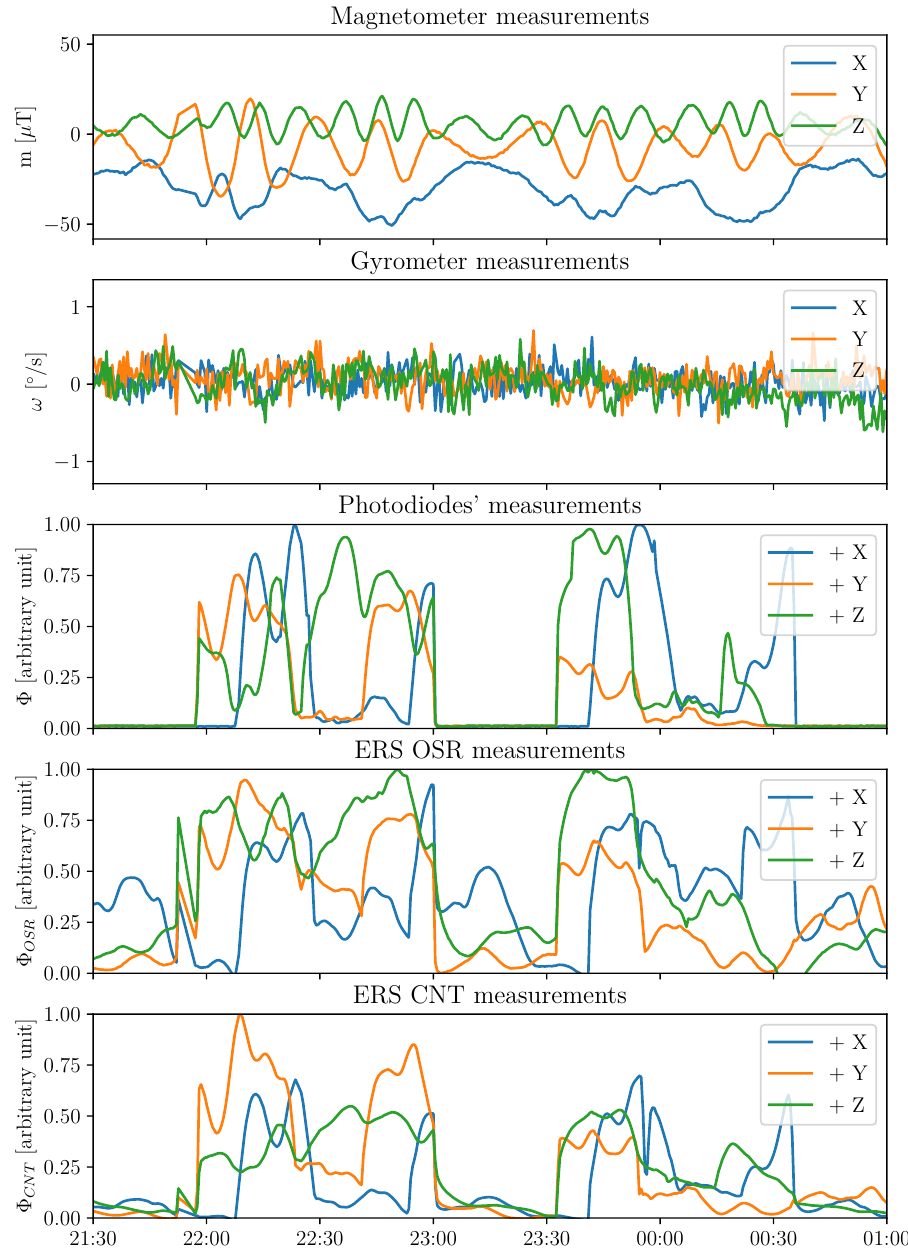
Figure 2. Time series of the measurements for two orbits on 26 March 2021 from the three-axis magnetometer, the three-axis gyrometer, the photodiodes, and the ERS